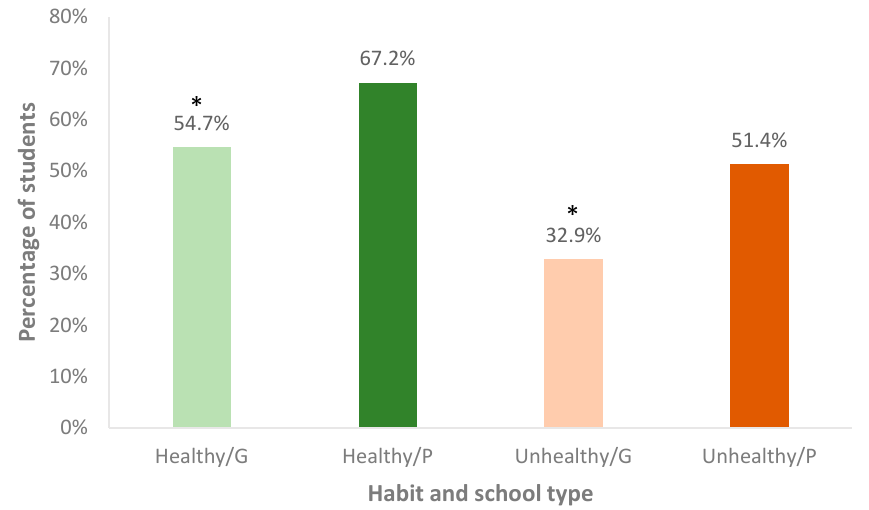
Figure 3. Percentage of students correctly identifying all five healthy habits from a picture in private (P) and government (G) schools. * Difference between P and G is statistically significant at p < 0.001.